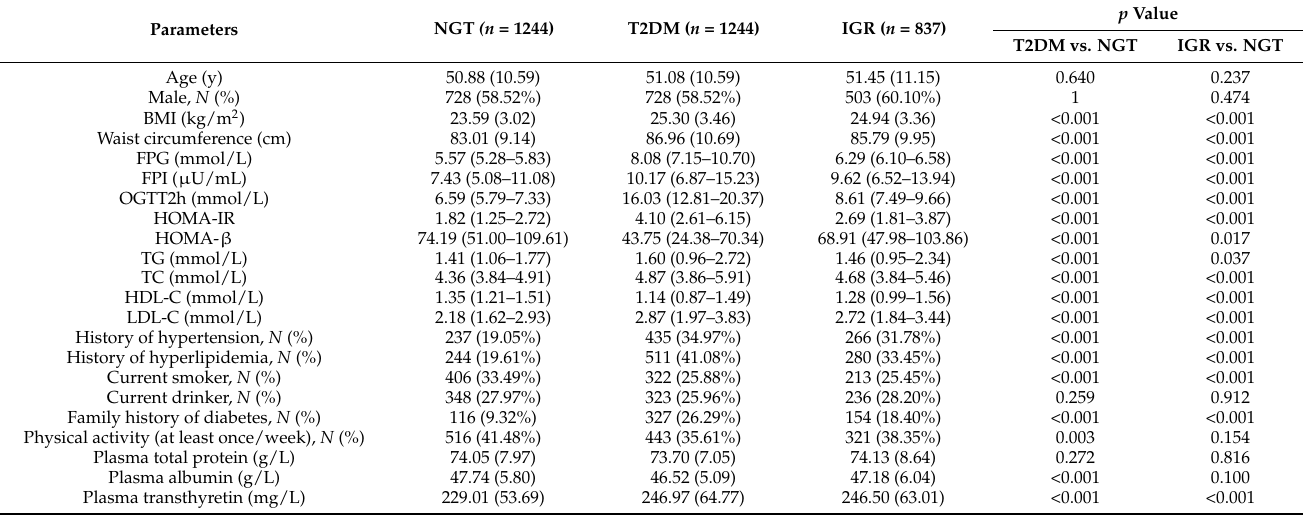
Table 1. Demographic and clinical characteristics of NGT, T2DM, and IGR